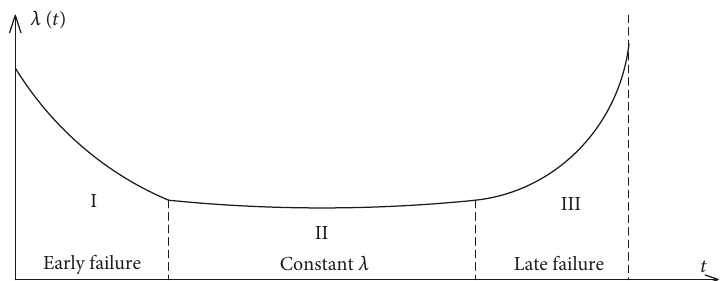
Figure 1: Failure rate in function of depreciation